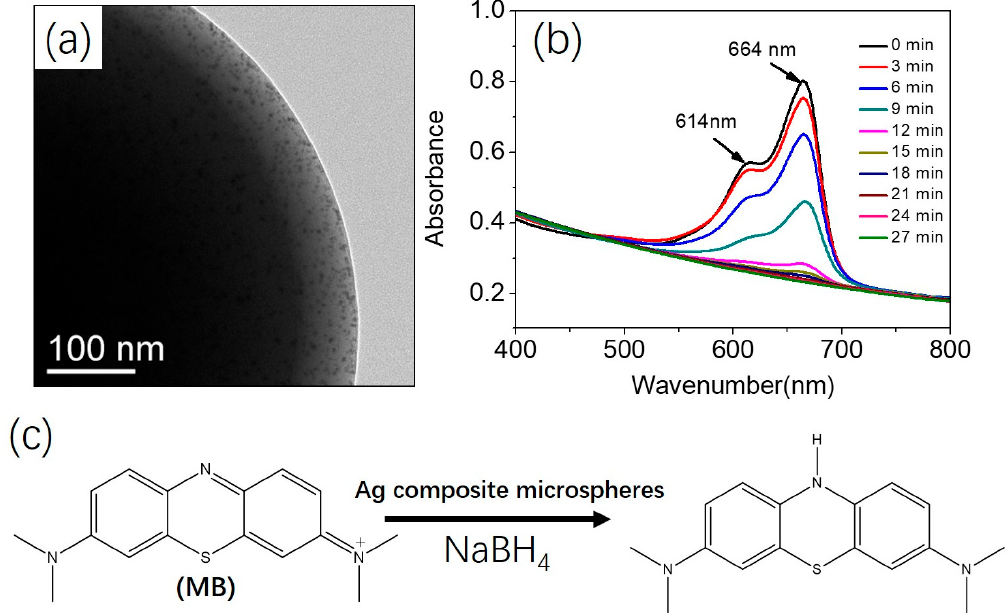
Figure 9. ( a ) TEM image of Ag composite microspheres, ( b ) UV-Vis absorption spectra for the catalytic reduction of methylene blue in water at room temperature using Ag composite microspheres as the catalyst, and ( c ) the reduction of methylene blue (MB) with NaBH 4 in the presence of Ag composite microspheres.